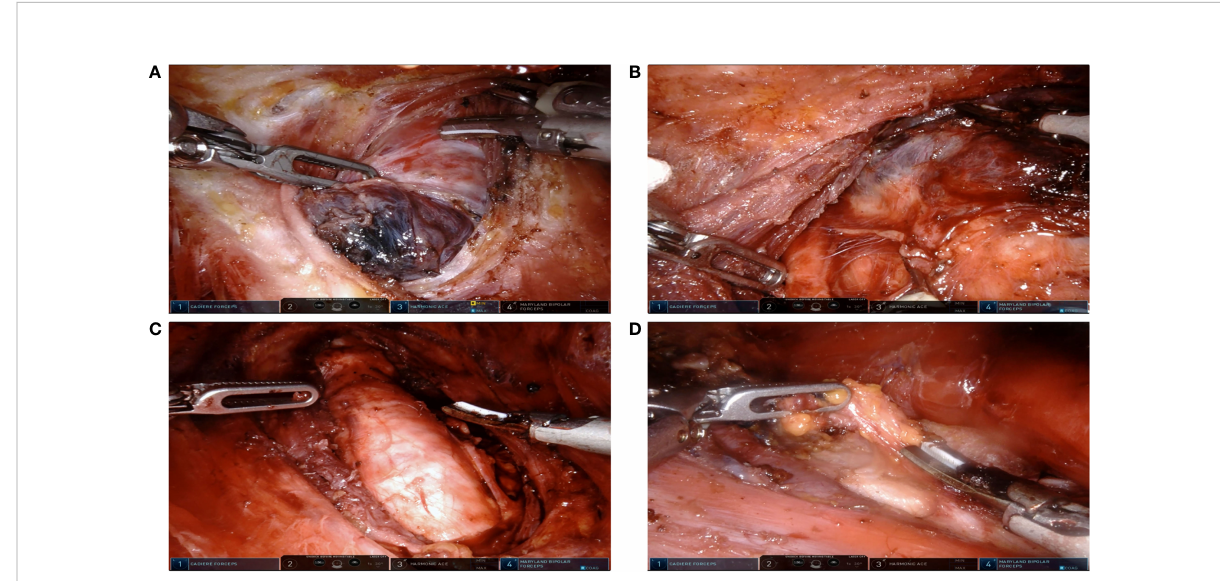
FIGURE 1 Extent of robotic surgeries. (A) Lobectomy due to benign thyroid nodules. (B) Lobectomy and ipsilateral Central Neck Dissection (CND) due to Papillary Thyroid Carcinoma (PTC). (C) Total thyroidectomy and ipsilateral CND due to PTC. (D) Total thyroidectomy with ipsilateral CND and lateral neck dissection. SCM were split longitudinally between its sternal head and clavicular